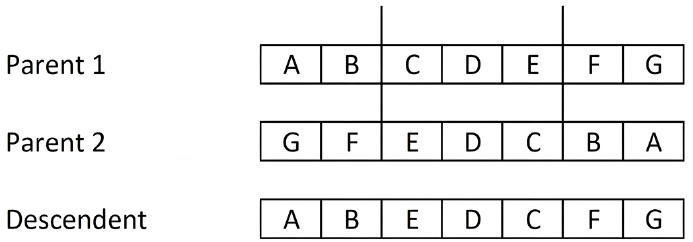
Figure 20. Example of a partial map crossover in a genetic algorithm. The offspring chromosome takes up complete fragments of one of the two parents, filling in its gaps with the genes still not present and in the order of appearance in the second parent.